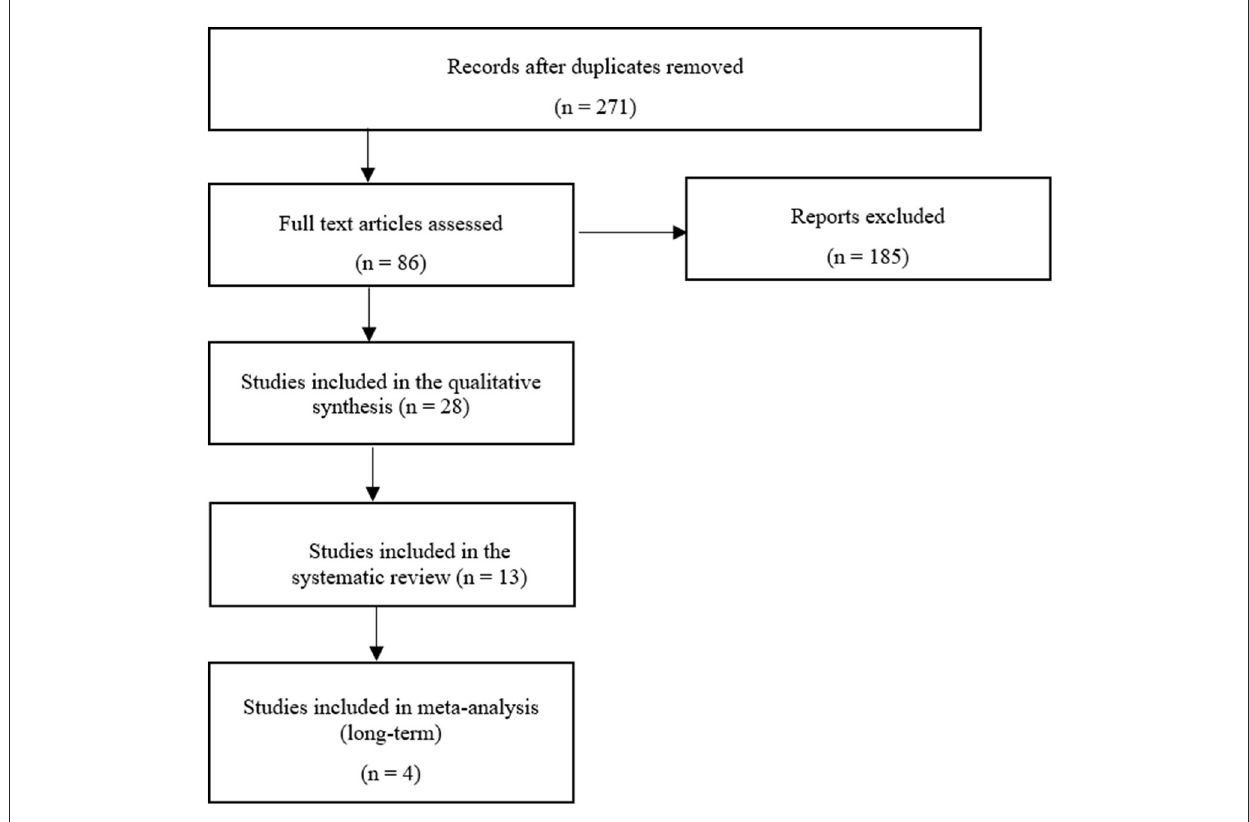
FIGURE3 Flow chart showing the methods used for the systemic search (93).